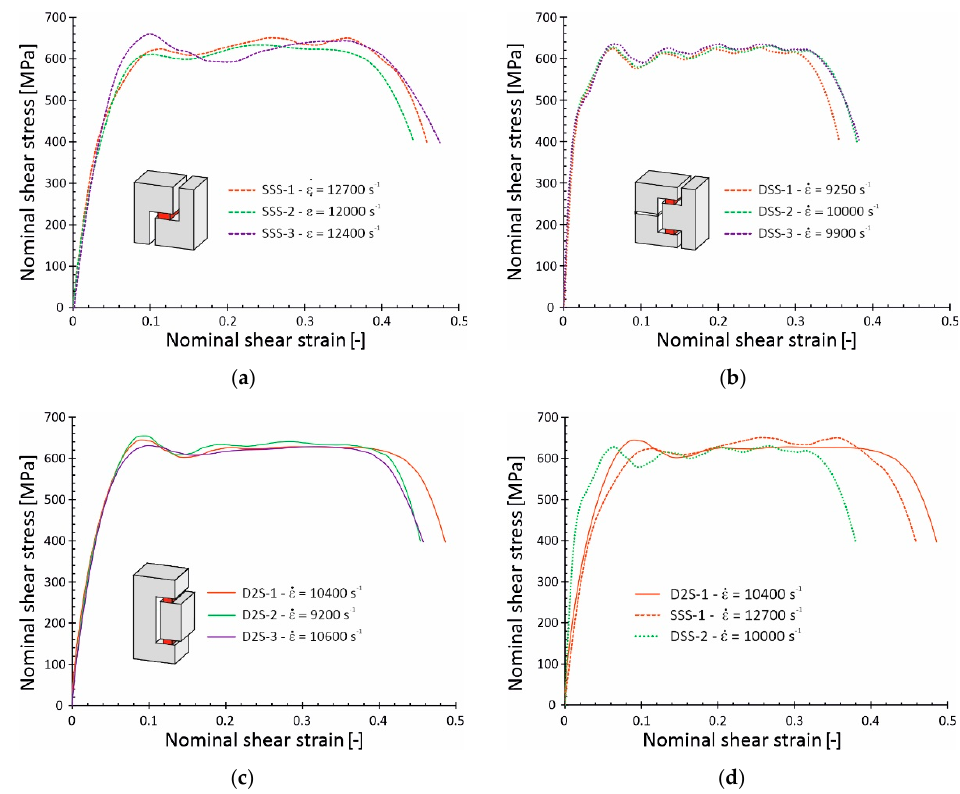
Figure 7. Nominal shear stress–strain curves for the Ti-6Al-4V alloy obtained from various specimen geometries: ( a ) SSS specimen; ( b ) DSS specimen; ( c ) D2S specimen; ( d ) curves comparison.